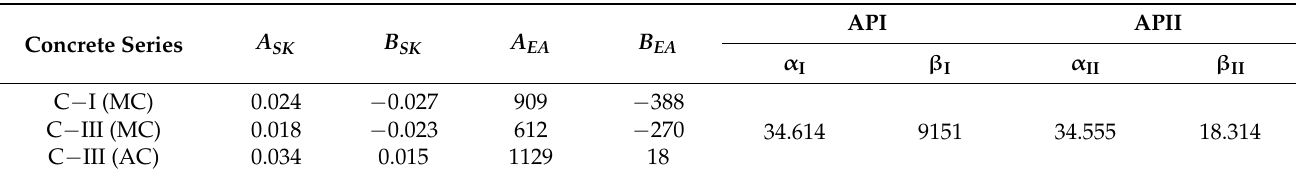
Table 6. Parameters determined with two methods.